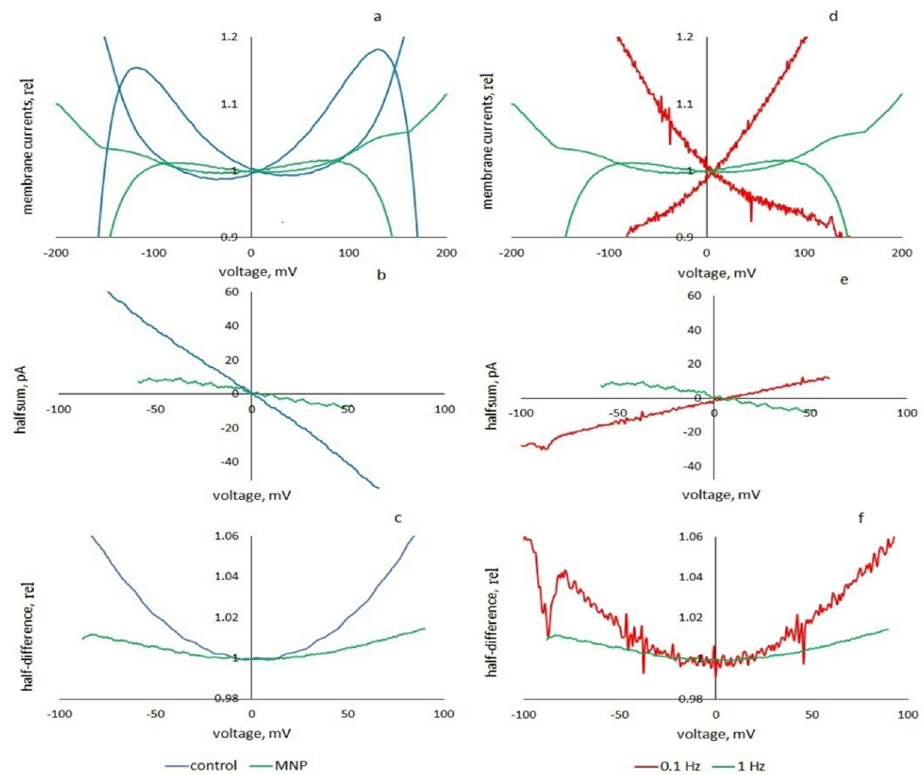
Figure 7. The effect of cobalt ferrite particles on the viscoelastic current responses of the membrane to a triangular voltage with an amplitude of 200 mV: hysteresis loops ( a , d ), apparent conductance currents (half ‐ sums) ( b , e ), and nonlinear capacitance dependences (half ‐ differences of experimental curves in relative capacitance units) ( c , f ). On the left—the effect of nanoparticles: the control and results are presented when particles are added, the frequency is 1 Hz; on the right—the influence of the signal frequency on the characteristics of the membrane with particles. The data are shown for frequencies of 1 and 0.1 Hz.